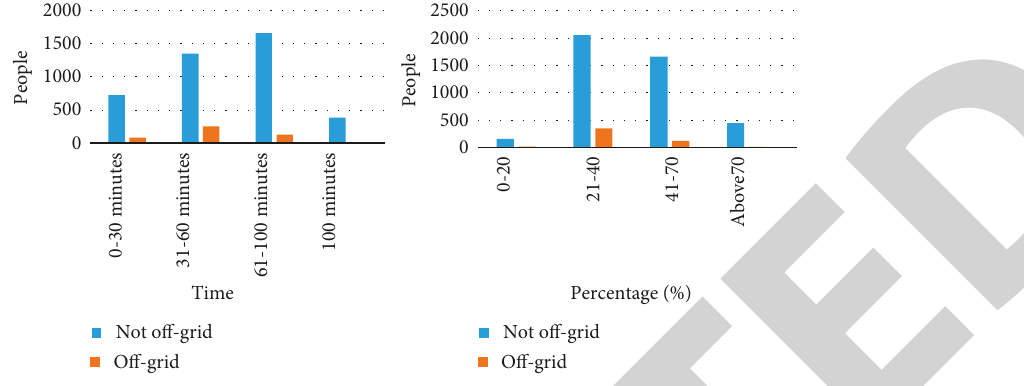
Figure 12: Statistics on the distribution of customer churn based on monthly customer call duration and caller ratio.